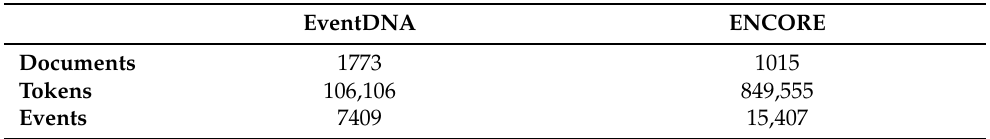
Table 2. Respective sizes of the two corpora, based on the number of documents, tokens and annotated events.